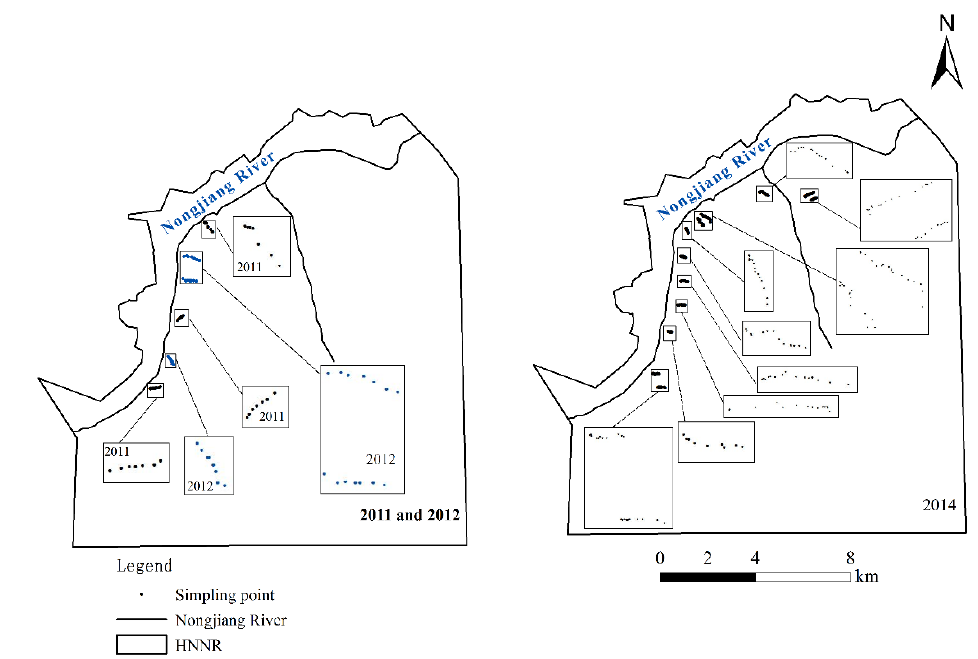
Figure 2. Location of the sampling spots.